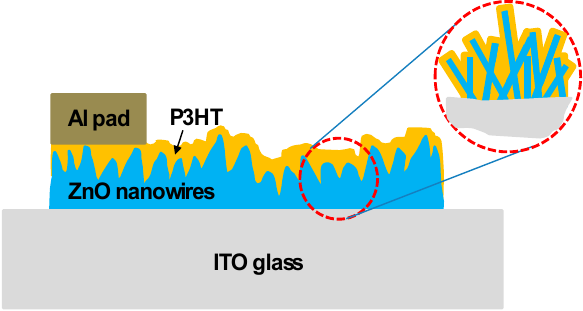
Figure 1. The process flow of removing the anodic aluminum oxide (AAO) template by the wet etching method.